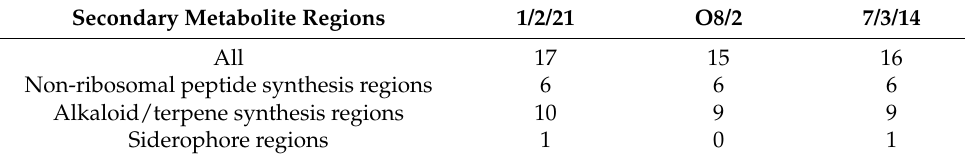
Table 2. Identified secondary metabolite regions for the different R. solani AG1-IB isolates. Secondary Metabolite